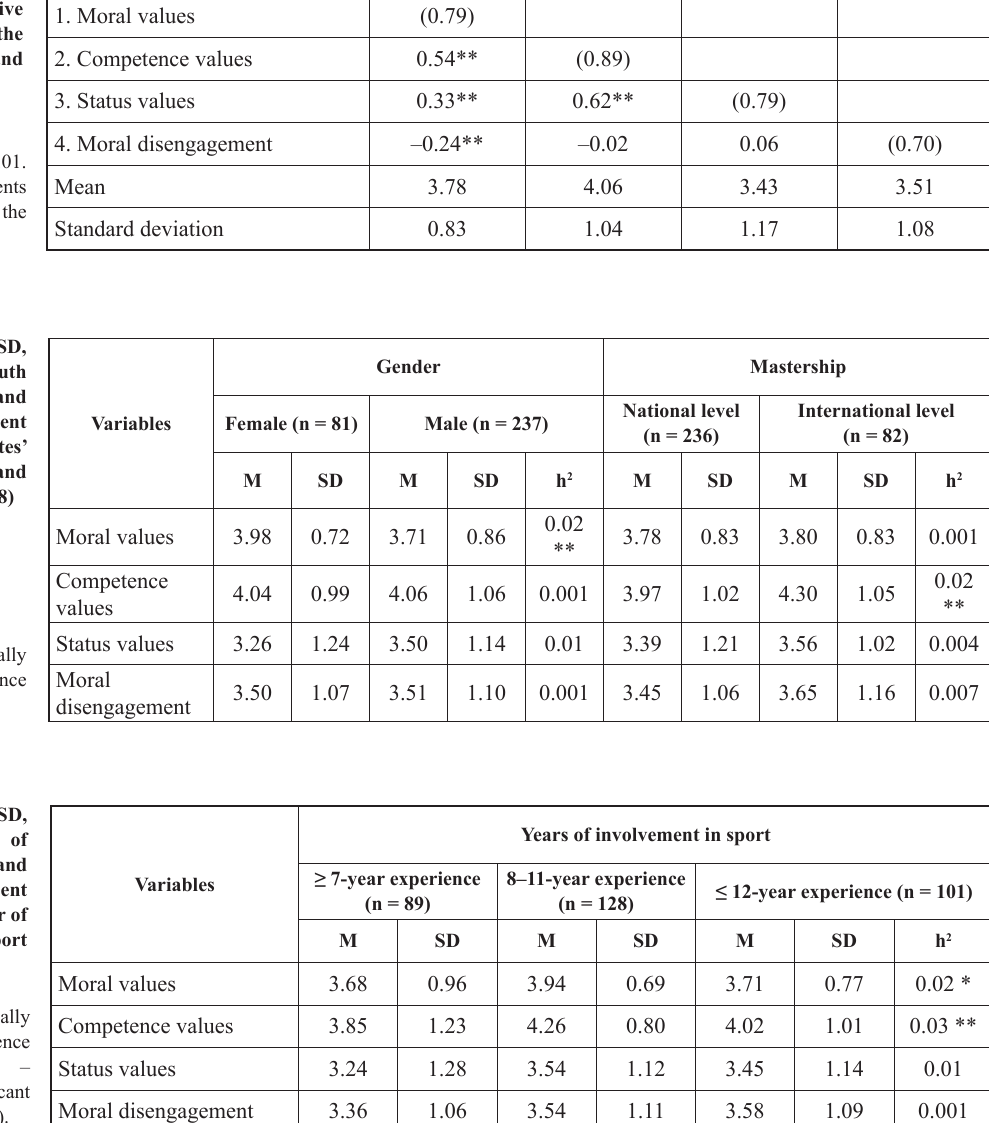
Table 1. Correlations, reliability estimates, and descriptive statistics for the YSVQ-2 and MDSS-S (n = 318)